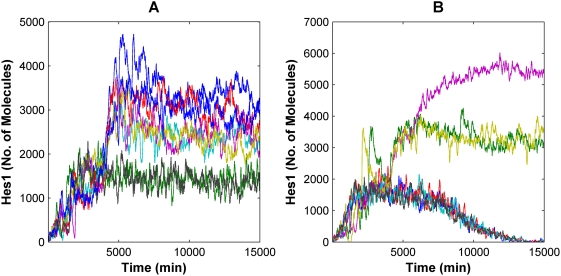
The Notch system exhibits bistability under stochastic simulations.(A) Hes1 stochastic trajectories are shown during high Delta levels for 4000 minutes, following which the Delta signal is brought down to levels that failed to switch the state to “ON” when provided for a prolonged duration (kDelp = 4×10−4) in the deterministic model. All the trajectories remain in the “ON” state – corresponding to the region of bistability seen in the deterministic simulations. (B) Hes1 stochastic trajectories are shown after application of a high Delta signal for 4000 minutes, after which the Delta signal is brought down to 0. Some trajectories persist in the “ON” state.